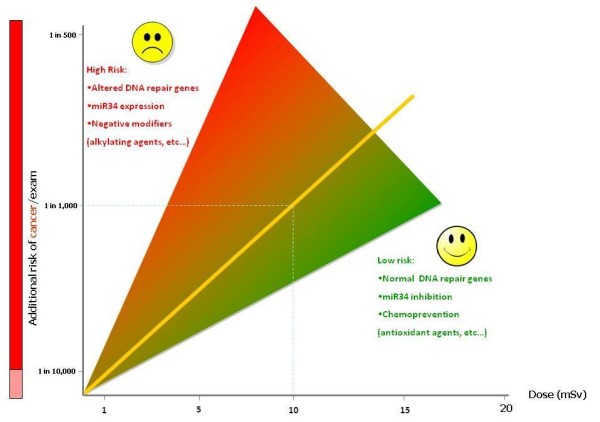
The population risk is in reality due to the average of a spectrum of risks, with higher risks being for instance associated with mutation of genes involved in DNA repair and with the presence of other environmental mutagens such as smoking.